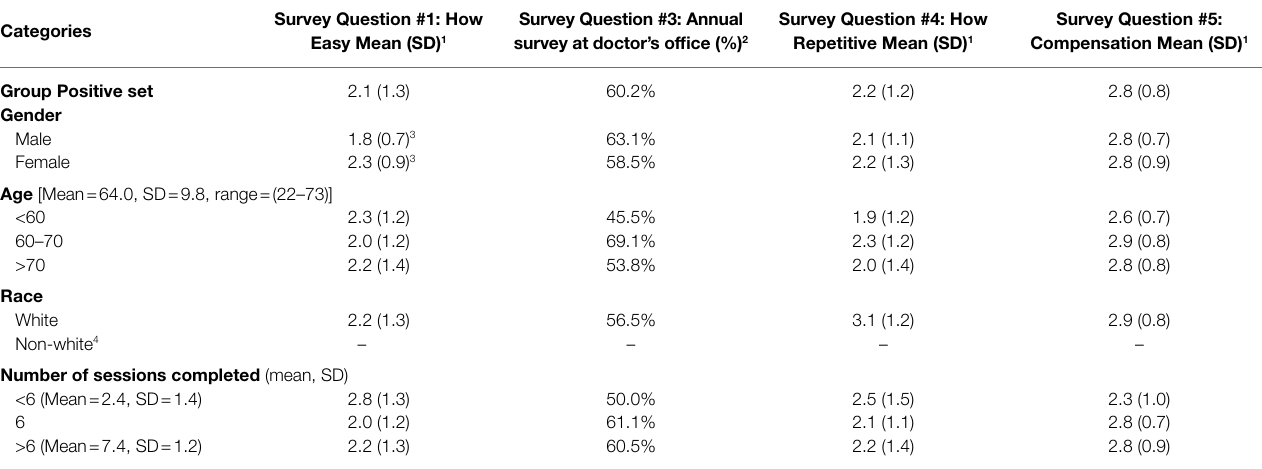
TABLE 7 | Demographics and survey answers (see Table 1 ) in Group Positive participants ( N = 103).